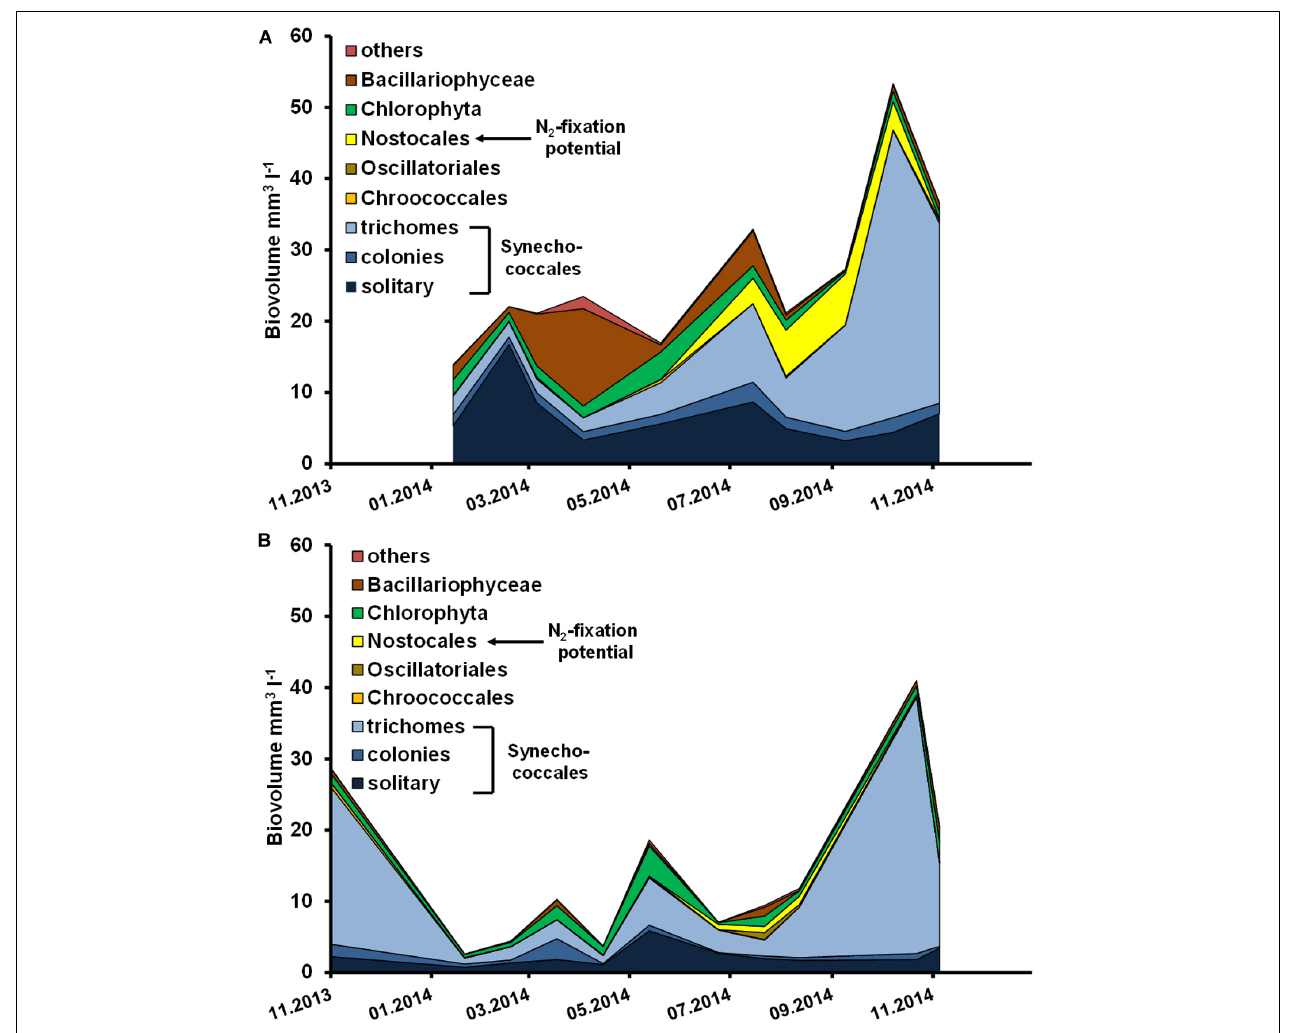
FIGURE 3 | Phytoplankton biovolume (mm − 3 l − 1 ) in the (A) Ribnitzer See from January to November 2014, and (B) Zingster Strom from November 2013 to November